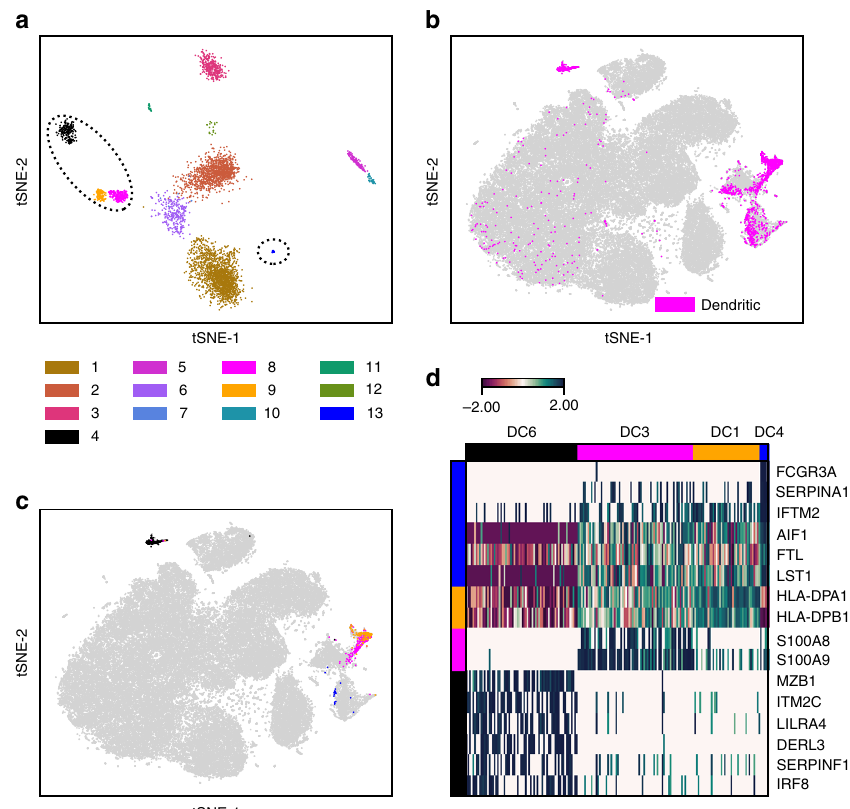
Fig. 7 Human blood dendritic cell heterogeneity delineated by FiRE. a t-SNE-based 2D plot of rare cells detected by FiRE. Cells are color coded based on their cluster identity as determined by dropClust 24 . b Dendritic cells, annotated by the authors, are highlighted in the 2D map adopted from Zheng et al. 3 . c Dendritic cell sub-types (DC6, DC3, DC1 and DC4) detected from FiRE-reported rare cells (R4, R8, R9 and R13) are color coded as per ( a